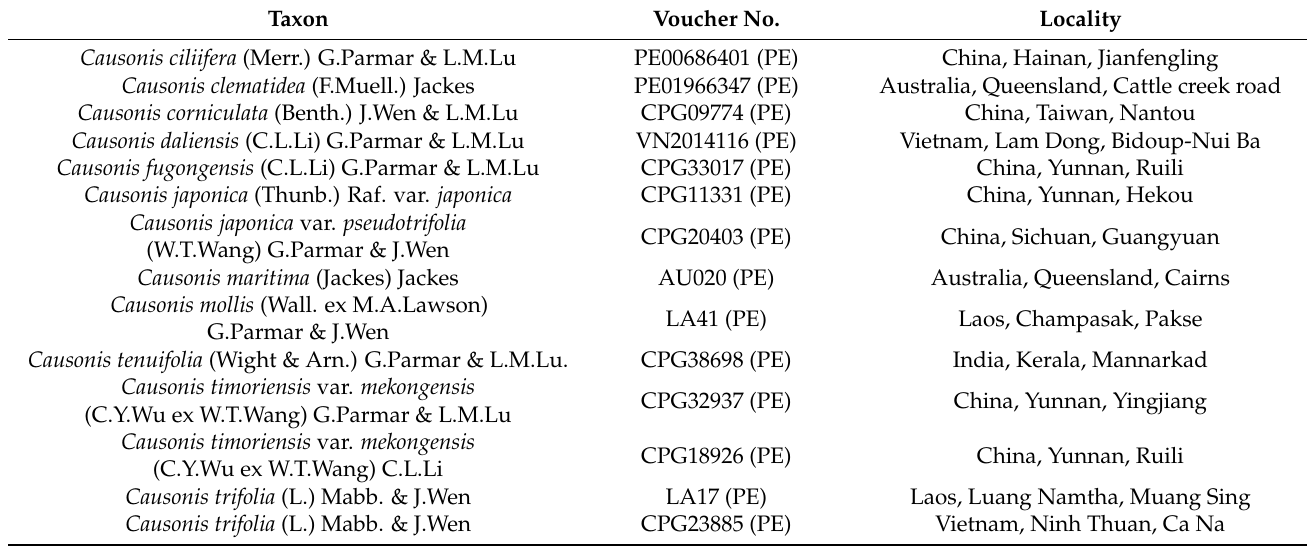
Table 1. Voucher information of samples used in this